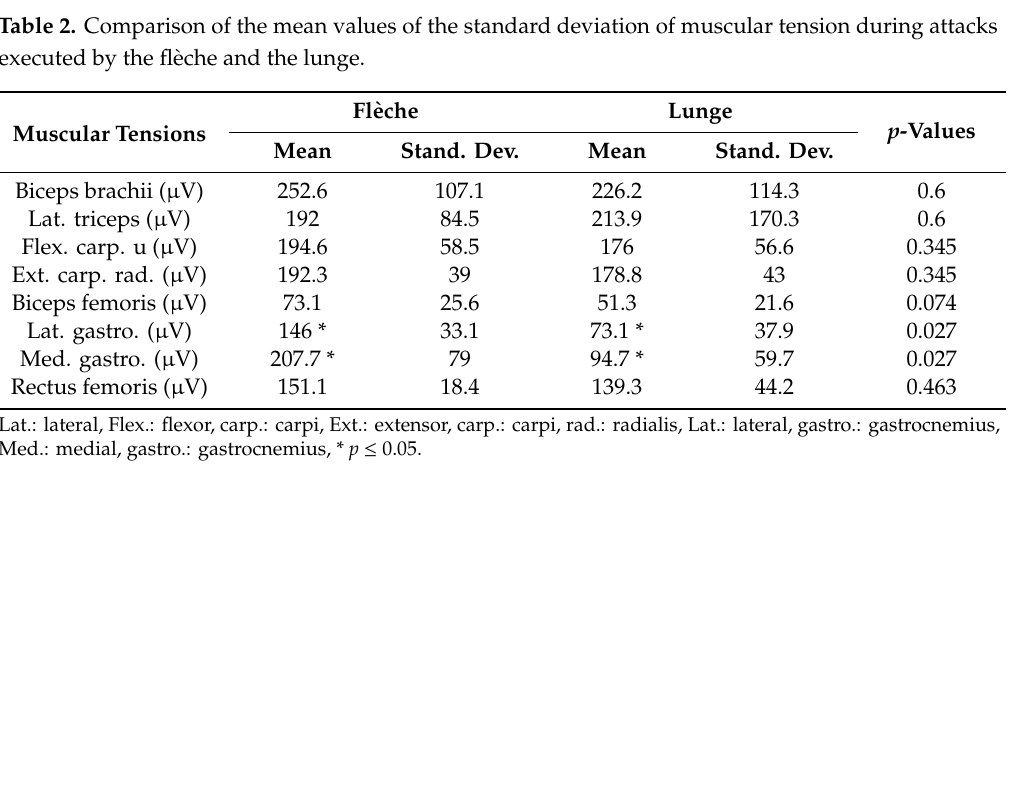
Table 1. Comparison of the mean values of the standard deviation of the reaction and movement times during an attack executed by the fl è che and the lunge. Fl è che Lunge Times Mean Stand. Dev. Mean Stand. Dev. p -Values 0.175